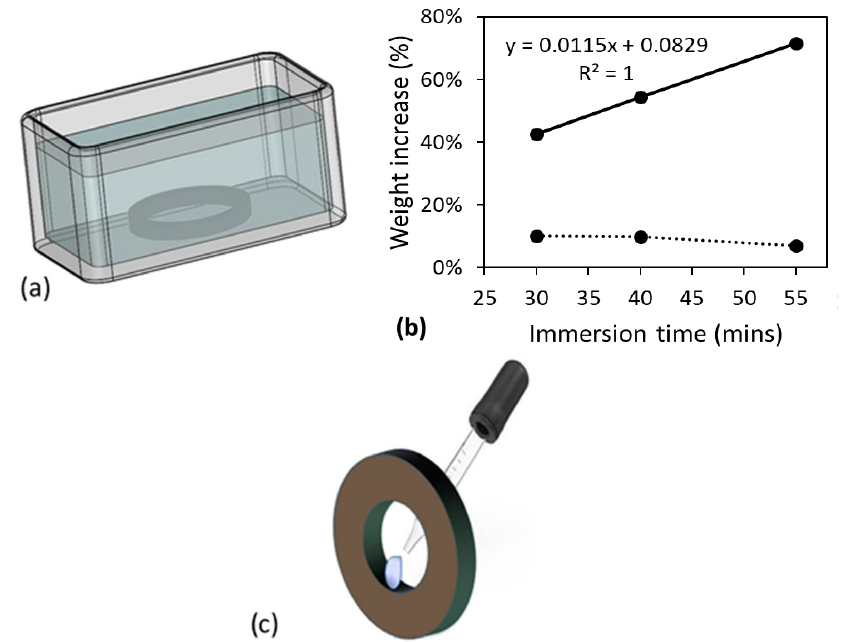
Figure 2. Specimen treatment methods used in this study: ( a ) setup for the immersion treatment, de- picted using a pipe ring specimen, ( b ) weight gain of dog-bone specimens as a function of immersion time in acetone, and ( c ) local treatment of a pipe ring specimen on its inner surface.